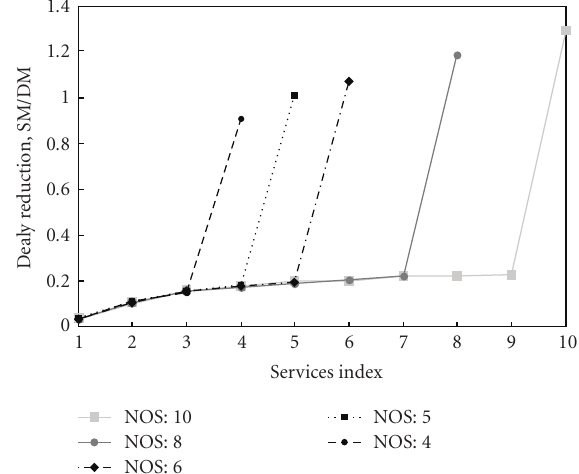
Figure 6: Delay reduction (StatMux delay to DetMux delay) for di ff erent number of multiplexed services (NOS).